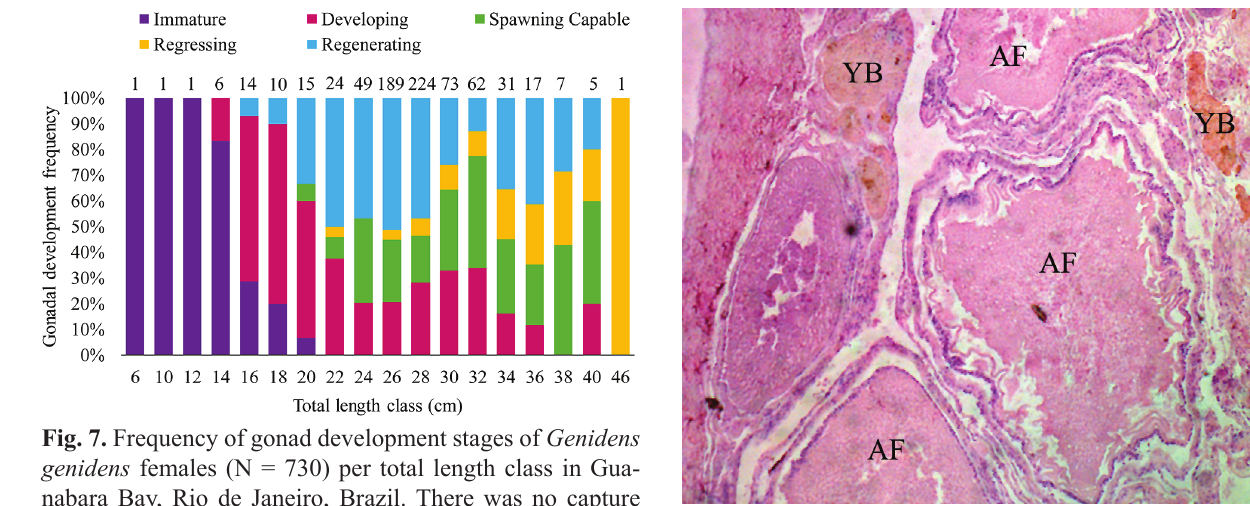
Fig. 8. Histological section of ovary of adult female smaller than 20 cm of Genidens genidens in Guanabara Bay, Rio de Ja- neiro, Brazil. Where: AF – atretic follicles; YB – yellow bodies.